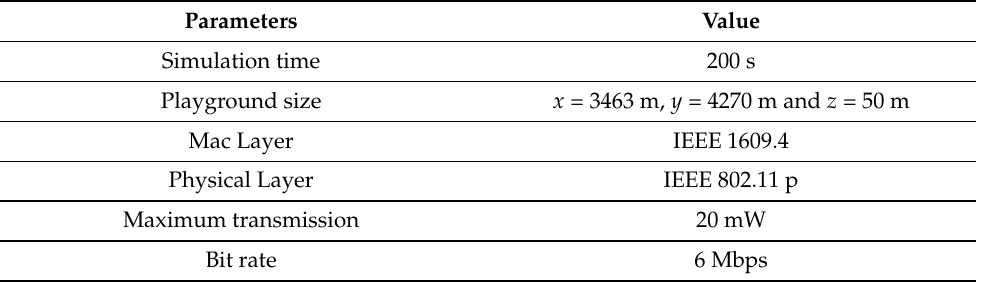
Figure 4. VANET simulation. Table 3. Simulation experiment